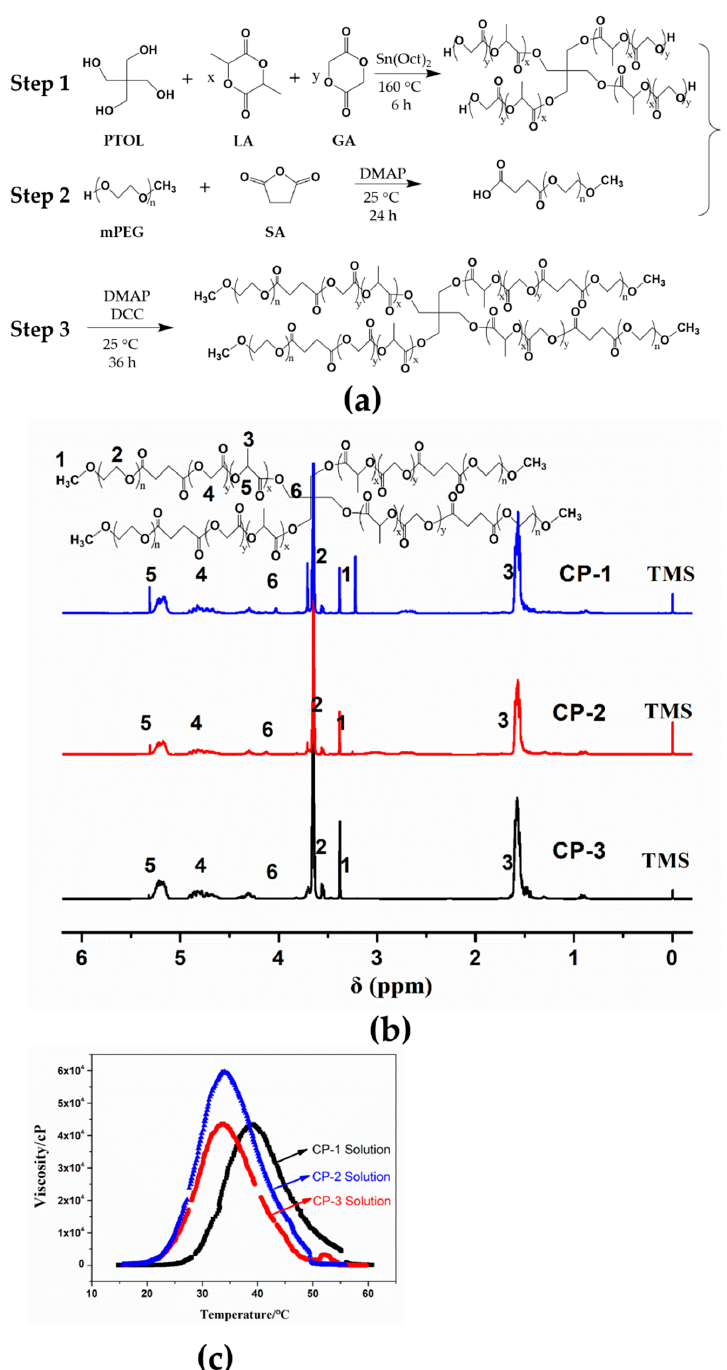
Figure 1. The preparation and characteristics of prepared poly( D,L ‐ lactic ‐ co ‐ glycolic acid) ‐ b ‐ methoxy poly(ethylene glycol) (4sPLGA ‐ mPEG) block copolymers. ( a ) The synthetic scheme of 4sPLGA ‐ mPEG block copolymer, ( b ) 1 H NMR spectra of 4sPLGA ‐ mPEG block copolymer with different LA/GA mol ratio (CP ‐ 1: LA/GA = 9; CP ‐ 2: LA/GA = 3; CP ‐ 3: LA/GA = 1), ( c ) viscosity versus temperature curves for three prepared block copolymers solutions, the copolymers were dissolved in simulation vaginal fluid solution (SVF) at the concentration of 30